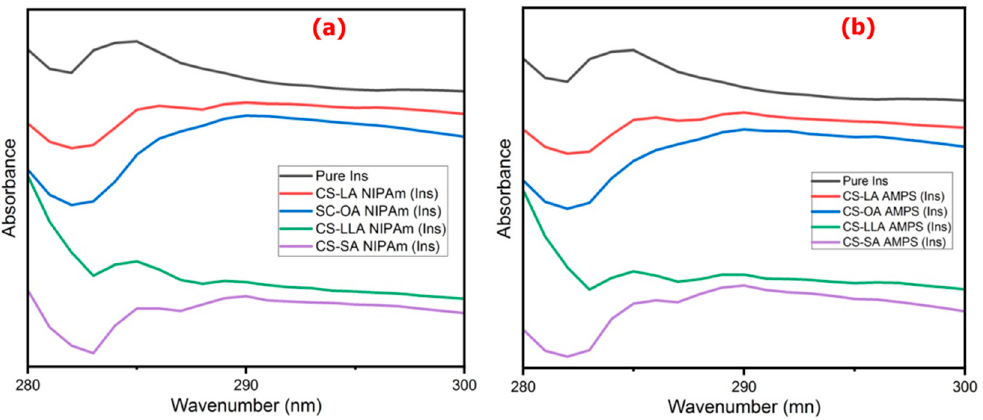
Figure 2. Comparison of UV-Vis spectrums for pure insulin and insulin-loaded CS-amides-modified ( a ) NIPAm; and ( b ) AMPS.